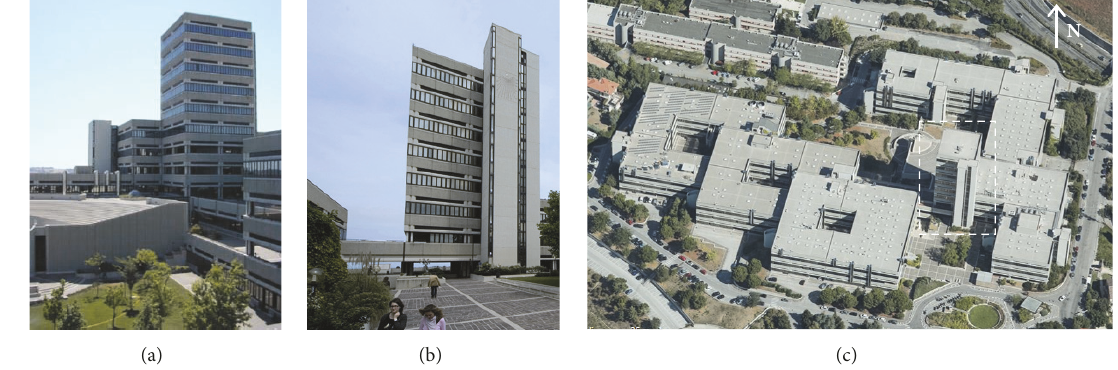
Figure 1: View of the Tower: (a) from North-West; (b) from South (c) aerial view from Bing